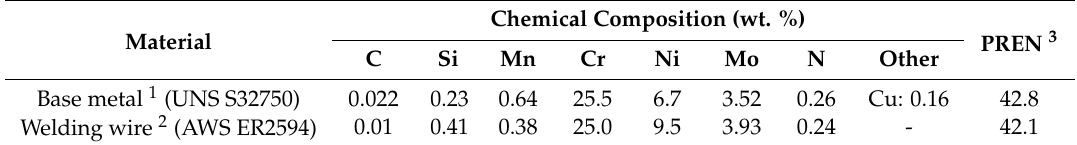
Table 1. Chemical composition of the base metal and welding wire.